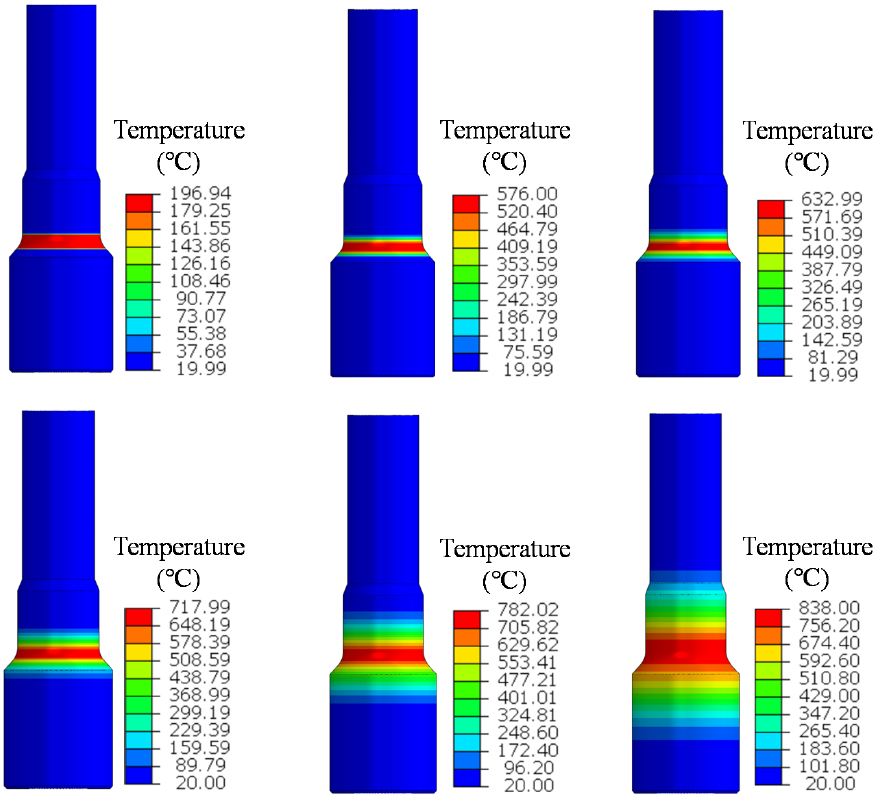
Figure 10. Temperature distribution contour of drill pipe outer wall at different time.